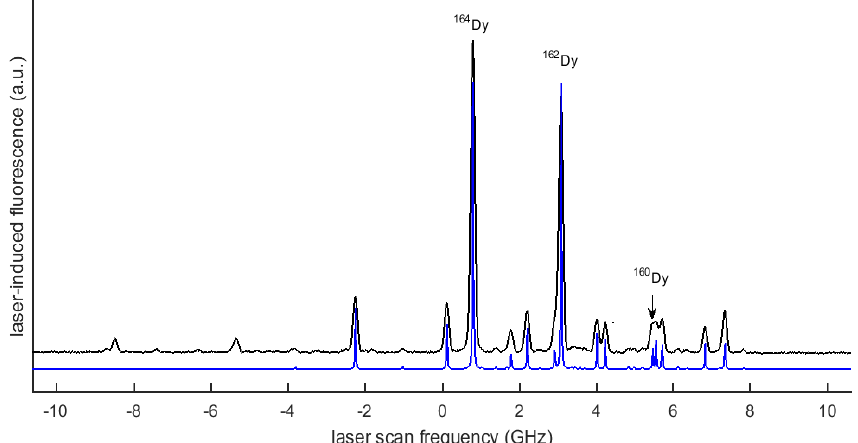
Figure 1. Laser-induced fluorescence spectrum of the transition 4 f 10 ( 5 I 6 )6 s 1/2 (6, 1 / 2 ) 13/2 –4 f 10 ( 5 I)6 p ° 13/2 at 438.430 nm in Dy II. The laser beam and ion beam were in parallel geometry. The observed spectrum (upper curve) is a single scan of 1024 channels at a dwell time of 400 ms per channel. The photomultiplier signal current for the 164 Dy peak was ~80 nA on a background of ~10 nA due to collisionally-induced light. The observed FWHM linewidth was 98.8 MHz, which includes the 10.6 MHz natural width. The lower ‘stick figure’ (blue online) shows the positions and amplitudes of the fitted components, and has been displaced vertically for clarity. The hfs components of 161 Dy and 163 Dy are not individually annotated. It is important to understand that the separations between peaks of different isotopes arise from a combination of IS and relative Doppler shift. Note that the components of a second, partially blended, transition are visible on the left side.